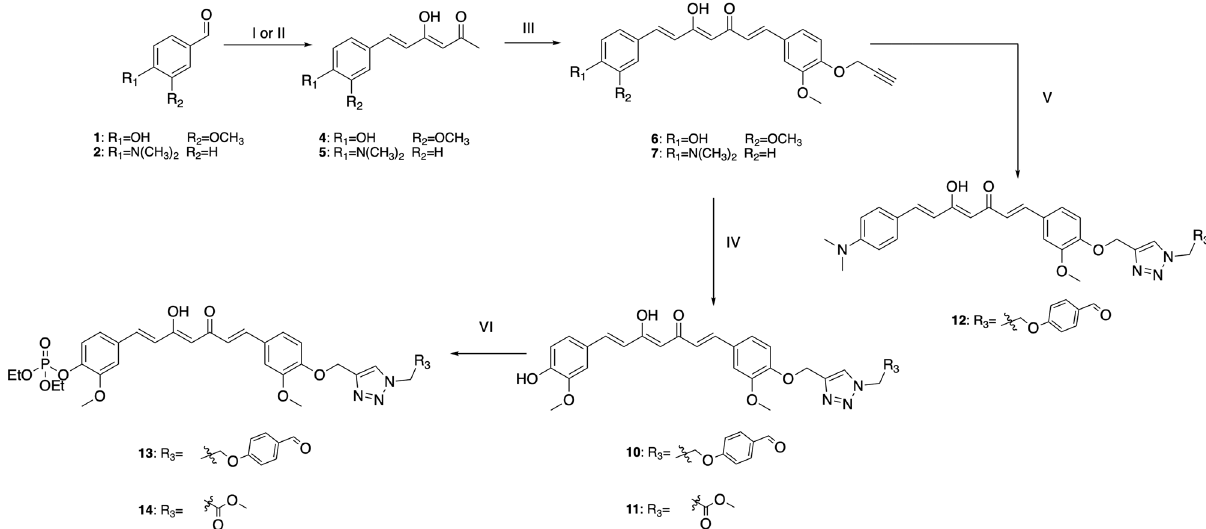
Fig. 1 Synthesis of compounds 10, 11, 12, 13 and 14. (I) Acetylacetone, boron oxide, trimethyl borate, n -butylamine, DMF; (II) acetylacetone, boron oxide, trimethyl borate, n -butylamine, EtOAc; (III) boron oxide, trimethyl borate, n -butylamine, DMF; (IV) CuSO 4 , Na-ascorbate, t-BuOH/H 2 O/CH 3 CN 2:1:1; (V) CuSO 4 , Na-ascorbate, t-BuOH/H 2 O/CH 3 CN 2:1:1; (VI) diethylchlorophosphate, TEA, CH 2 Cl 2